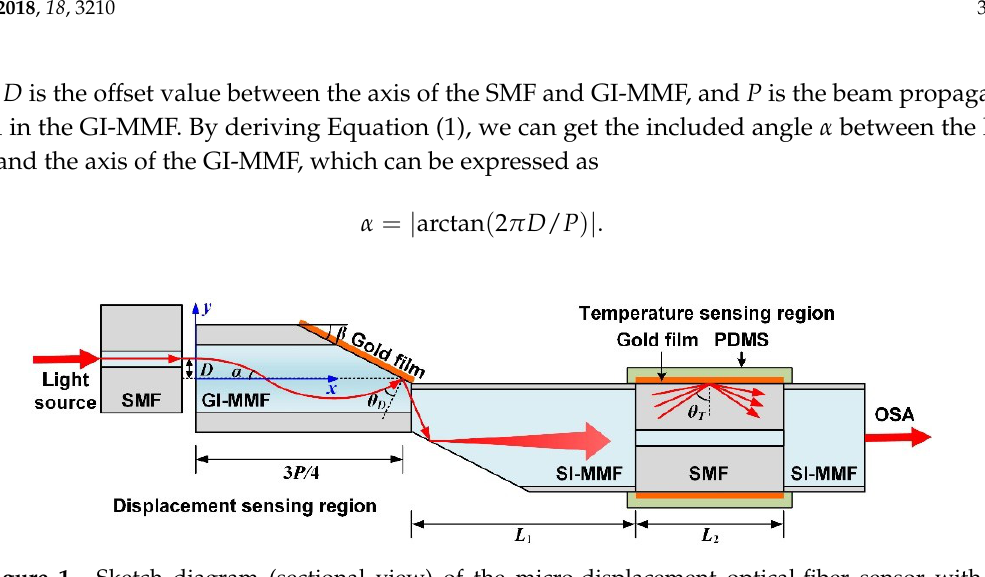
Figure 1. Sketch diagram (sectional view) of the micro-displacement optical-fiber sensor with temperature compensation.